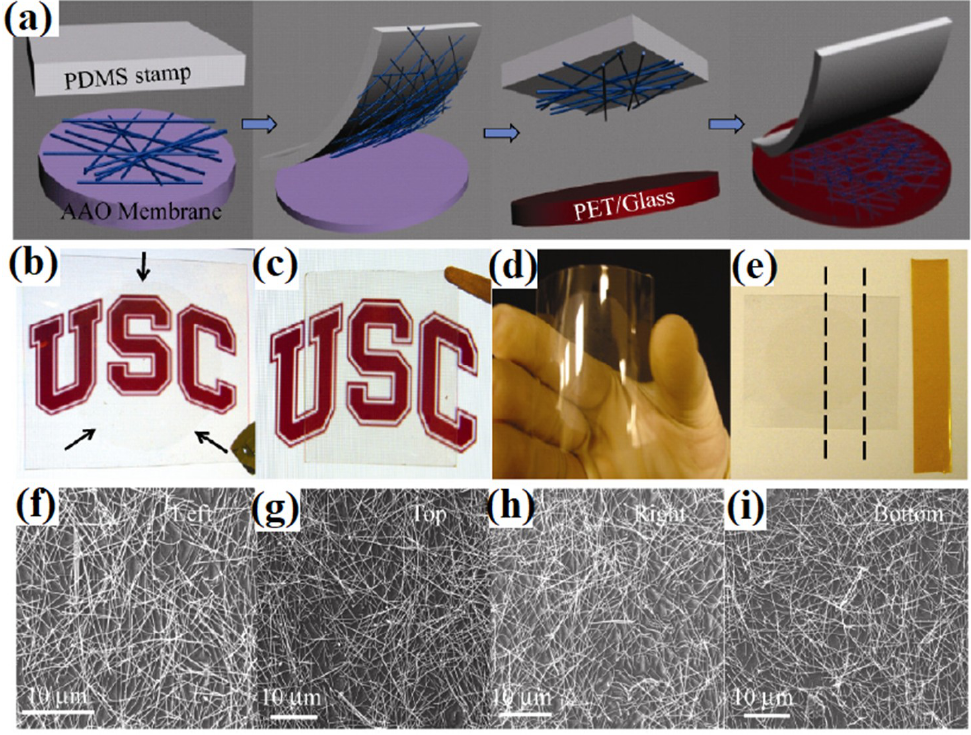
Figure 9. ( a ) Schematic transfer process of Ag NWs from anodized aluminum oxide membrane to PET substrate by using Poly(dimethylsiloxane) (PDMS) stamp; ( b ) Ag NW thin film on PET substrate; ( c ) Ag NW thin film on glass substrate; ( d ) flexibility of the Ag NW thin film on PET substrate; ( e ) adhesion test shows remaining Ag NWs on PET after peeling off the sticky tape from the area between dotted line. SEM images of the ( f ) left, ( g ) top, ( h ) right, and ( i ) bottom regions of the thin film to show the uniformity of the film across the entire area. Reproduced with permission from [28]. Copyright 2010 Springer Publishing.